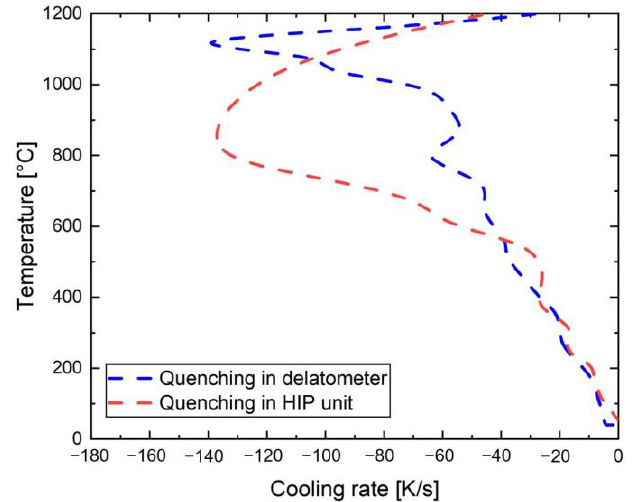
Figure 3. Cooling rate in dilatometer and HIP unit.